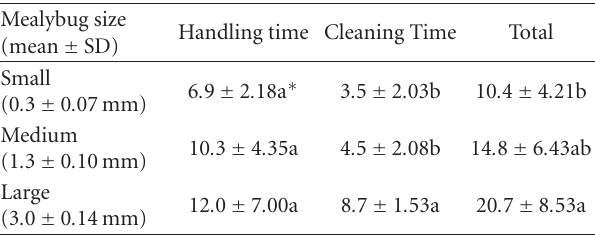
Table 2: Handling and cleaning time (minutes ± SD) of C. montrouzieri adults feeding on di ff erent sizes of